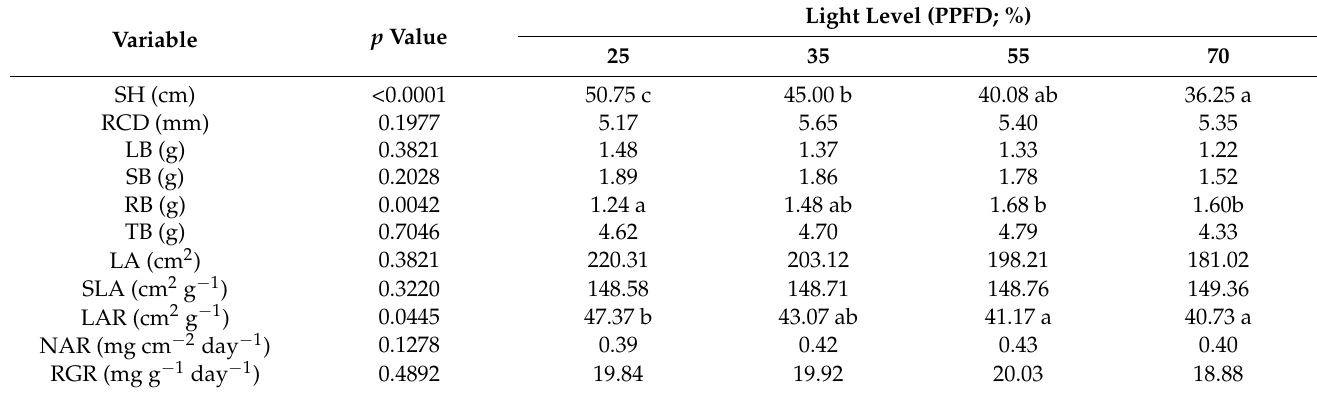
Table 3. Statistical significance and averages ( n = 12) in morphology variables, net assimilation rate and growth of Enterolobium cyclocarpum plants exposed to varying photosynthetic photon flux density (PPFD) levels. For the same variable, means with letters in common are not significantly different ( p > 0.05) according to Fisher’s LSD test ( α = 0.05). SH, shoot height; RCD, root-collar diameter; LB, leaf biomass; SB, stem biomass; RB, root biomass; TB, total biomass; LA, leaf area; SLA, specific leaf